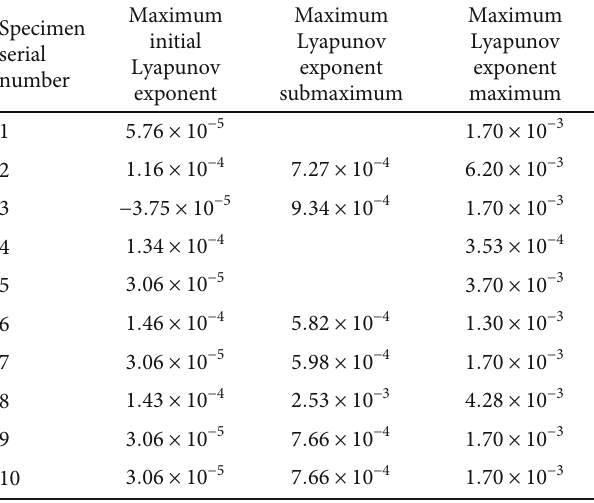
Table 3: Summary table of maximum Lyapunov exponent.